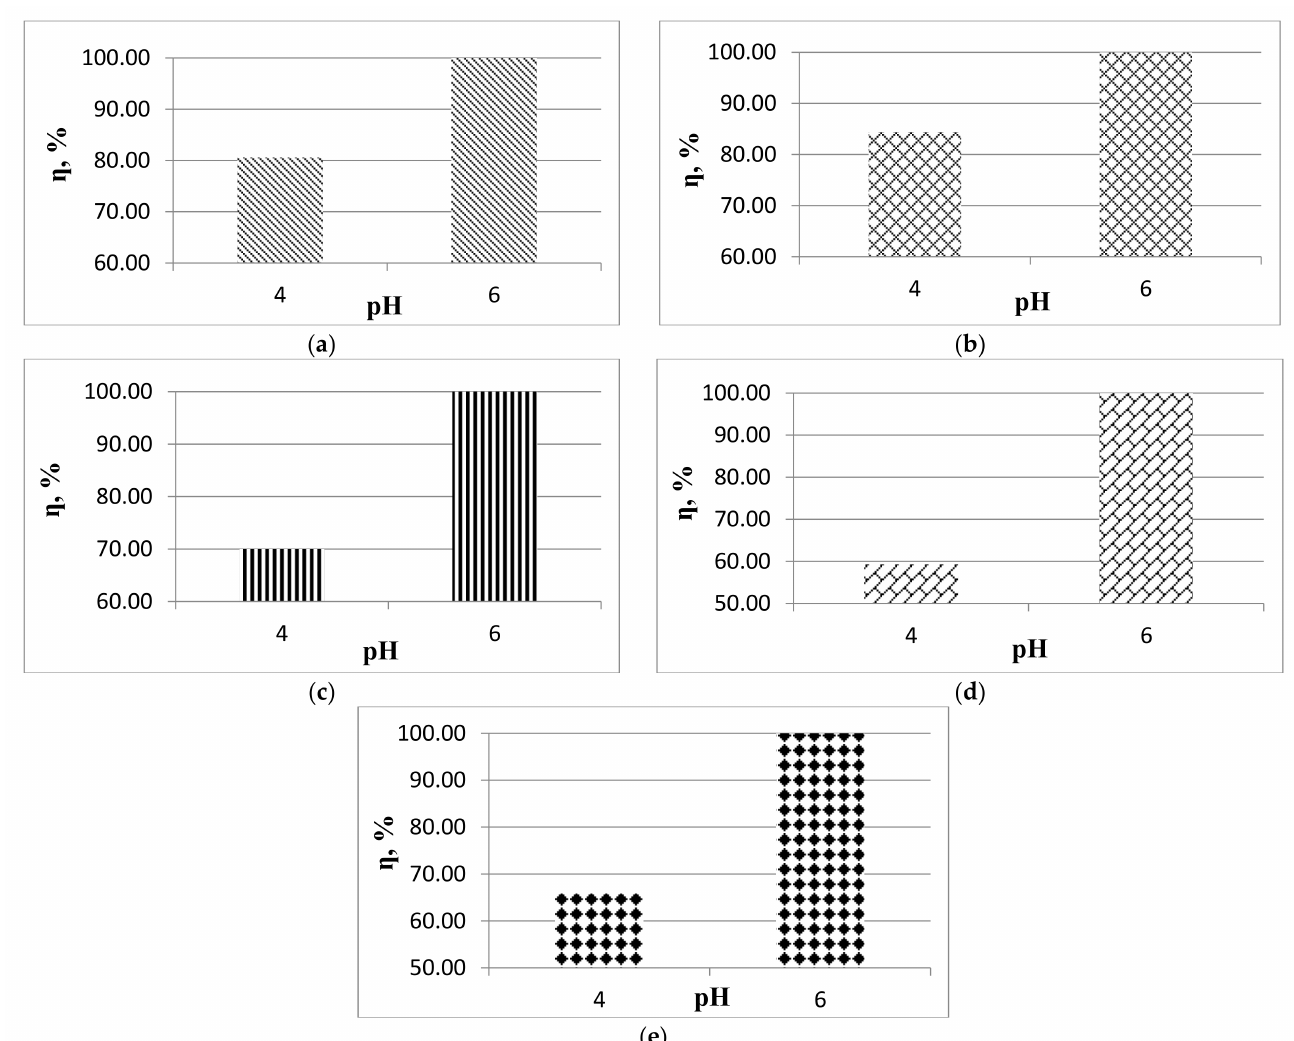
Figure 2. The pH effect on the removal process of Pb (II) ions (conditions: metal ion concentration 0.70 ( a ); 1.00 ( b ); 1.20 ( c ); 1.45 ( d ); 1.64 ( e ) mg/L).